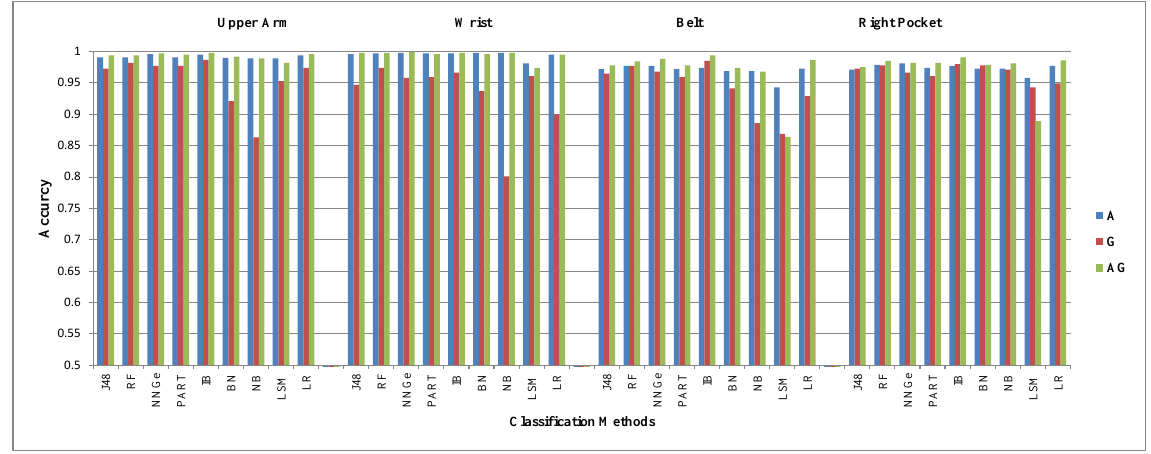
Figure A.2. Recognition performance for the jogging activity on all four positions using FS2.